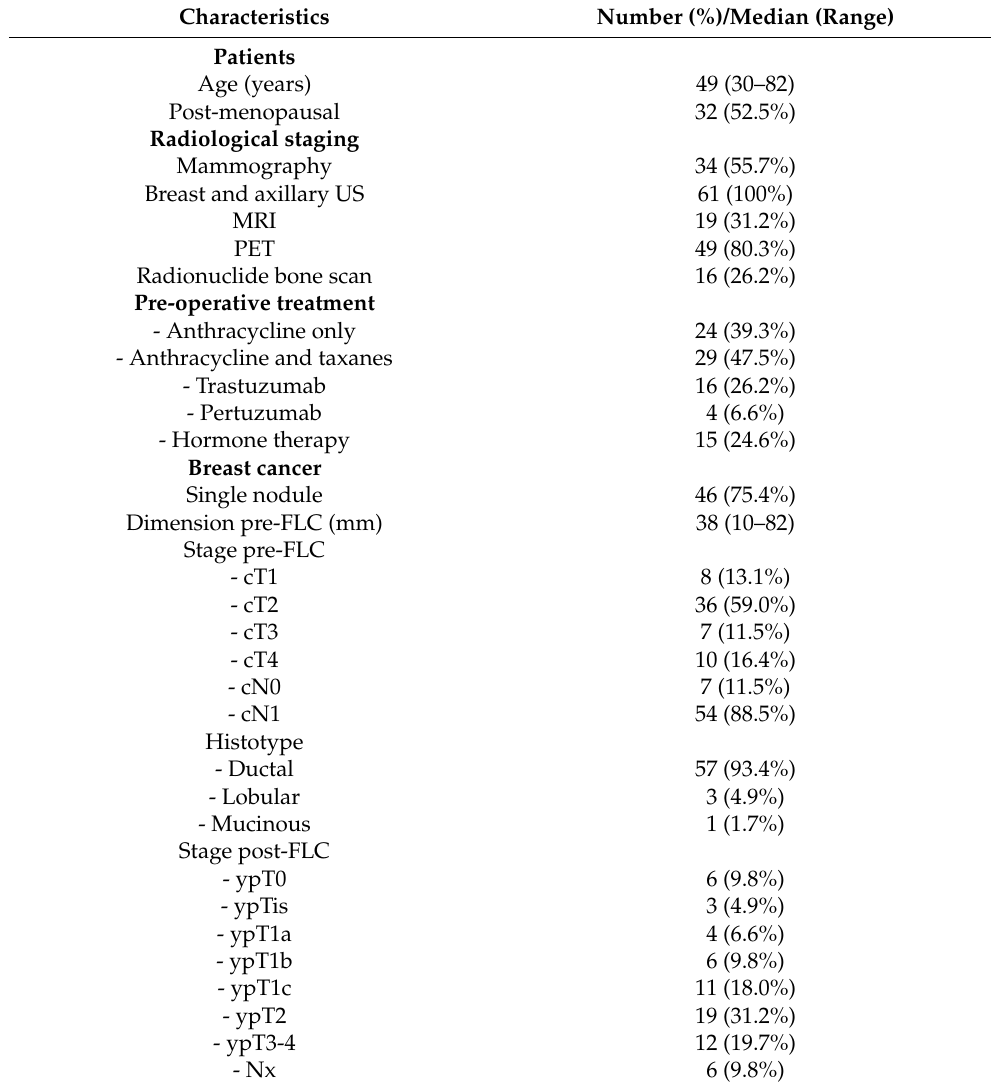
Table 1. Characteristics and treatment of 61 de novo metastatic breast cancer patients undergoing front-line chemotherapy and loco-regional